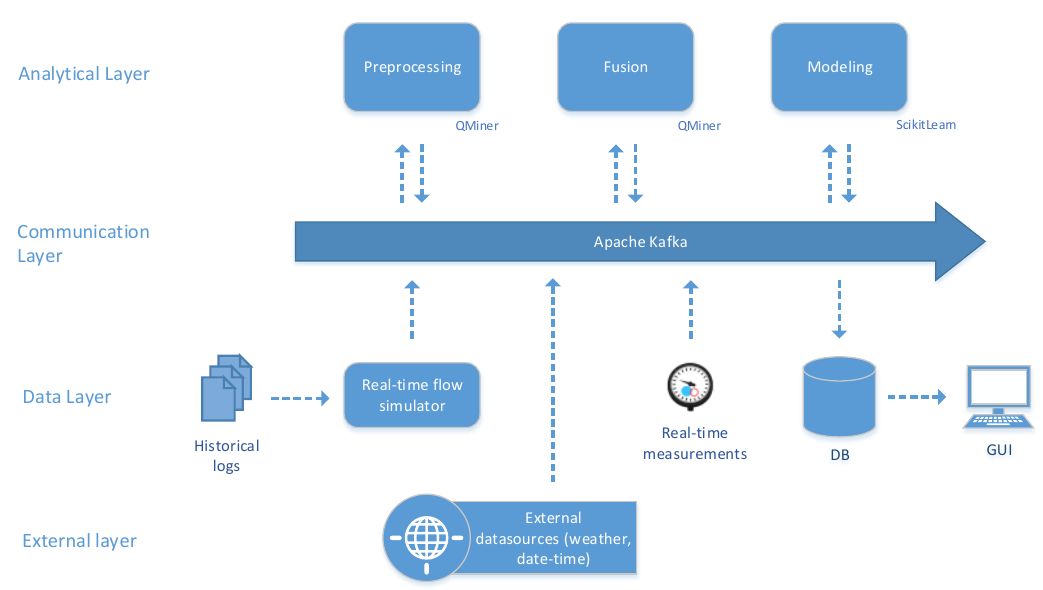
Figure 4. Integration in the cloud infrastructure is based on the message queue in the Communication Layer (in our applications this was Apache Kafka). Each component in the architecture is loosely coupled to the system and receives/sends data to the system via the message queue using a predefined data format. The system can receive simulated or real-time data (from sensors and from external data sources). Results are stored in the monitoring database (DB) and finally shown to the user